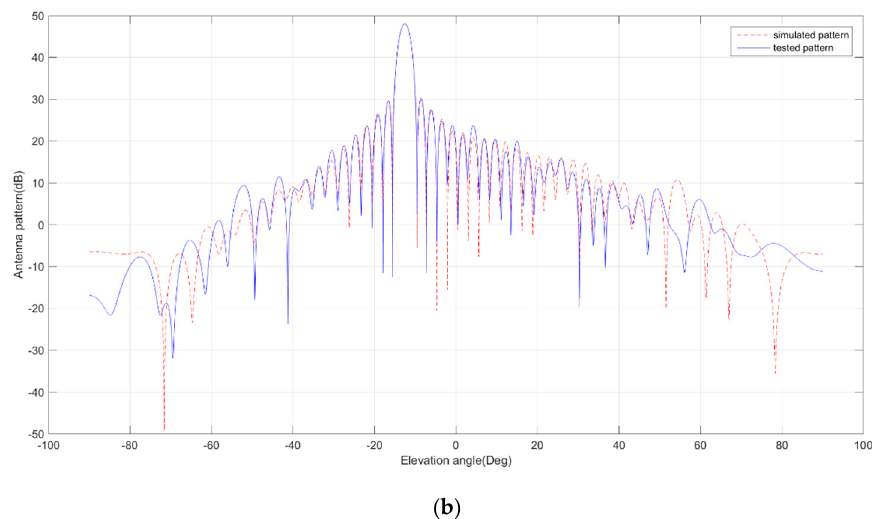
Figure 7. Comparison of simulated and tested patterns of Q1 beam within the full elevation range. ( a ) H-polarization transmitting patterns; ( b ) H-polarization receiving patterns.